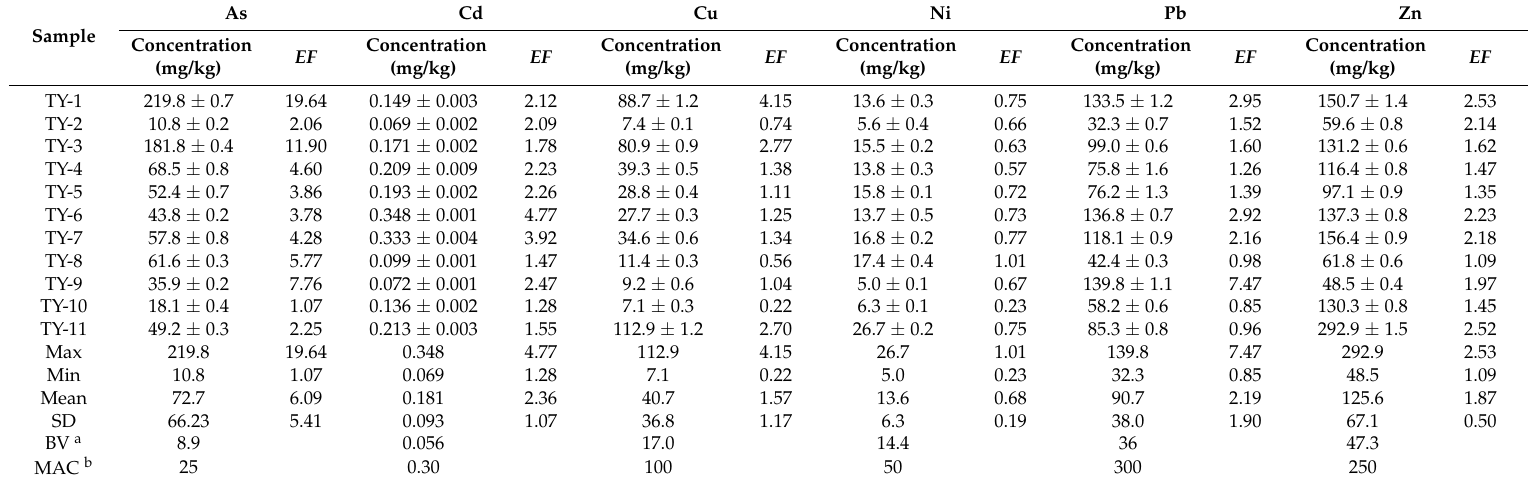
Table 2. Concentrations and enrichment factors ( EFs ) of metal(loid)s in top soils from the study area.